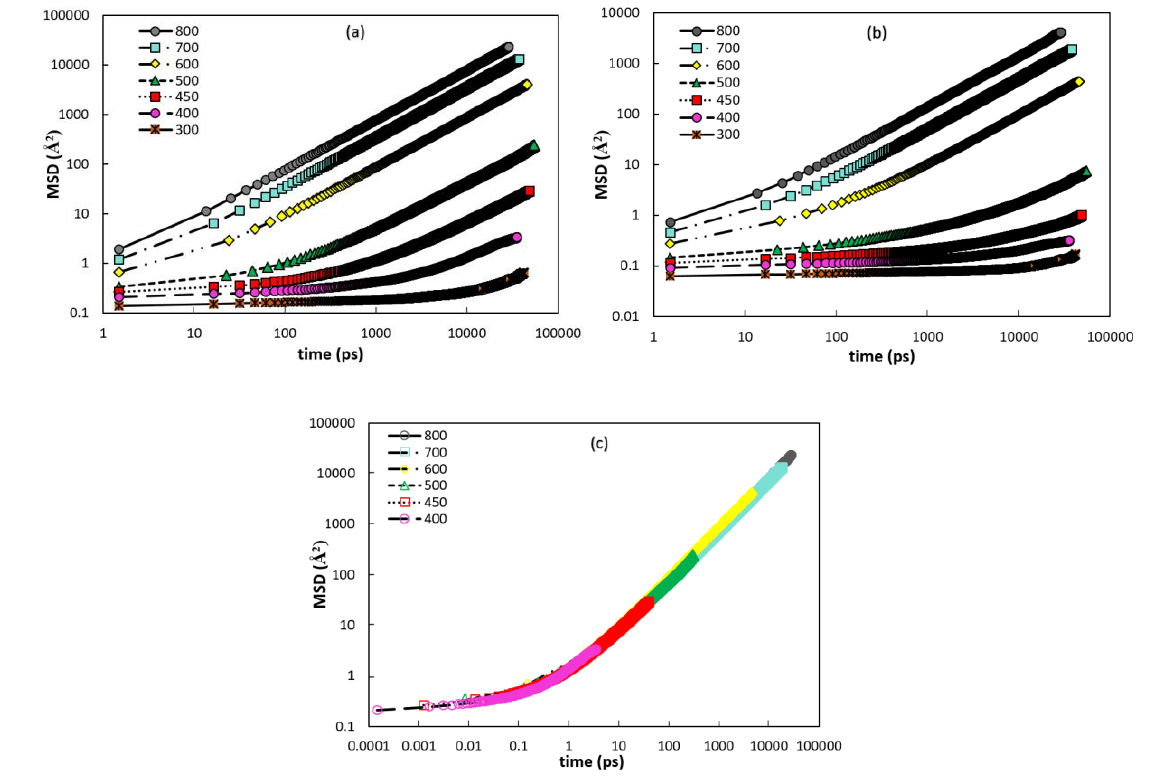
Figure 4. Mean squared displacements of ( a ) Li + and ( b ) CO 32− as obtained from MD simulations of amorphous Li 2 CO 3 systems at various temperatures. Panel ( c ) shows the master curve for Li MSD(t) obtained using the time-temperature superposition principle.